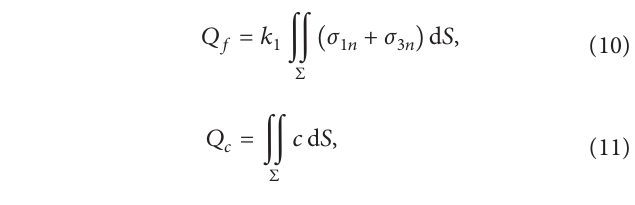
Figure 8: c r predicted by regression relationship between τ and σ in the Mohr stress space. (a) ( σ t ) t is not included in regression. (b) ( σ t ) t is included in